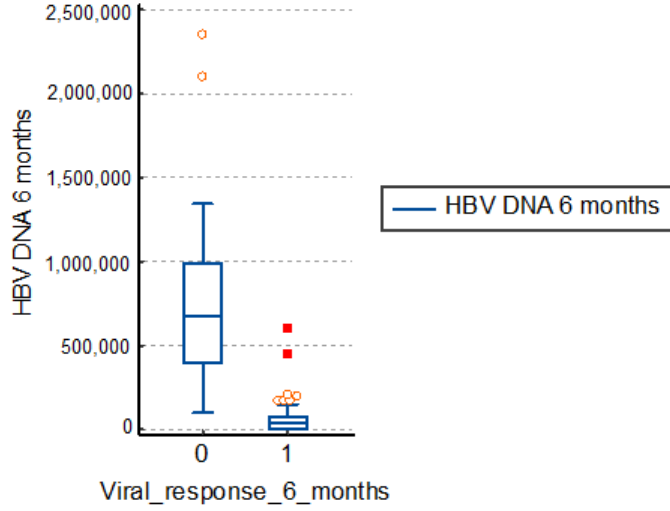
Figure 2. Distribution of viremia at 6 months. HBV: hepatitis B virus.